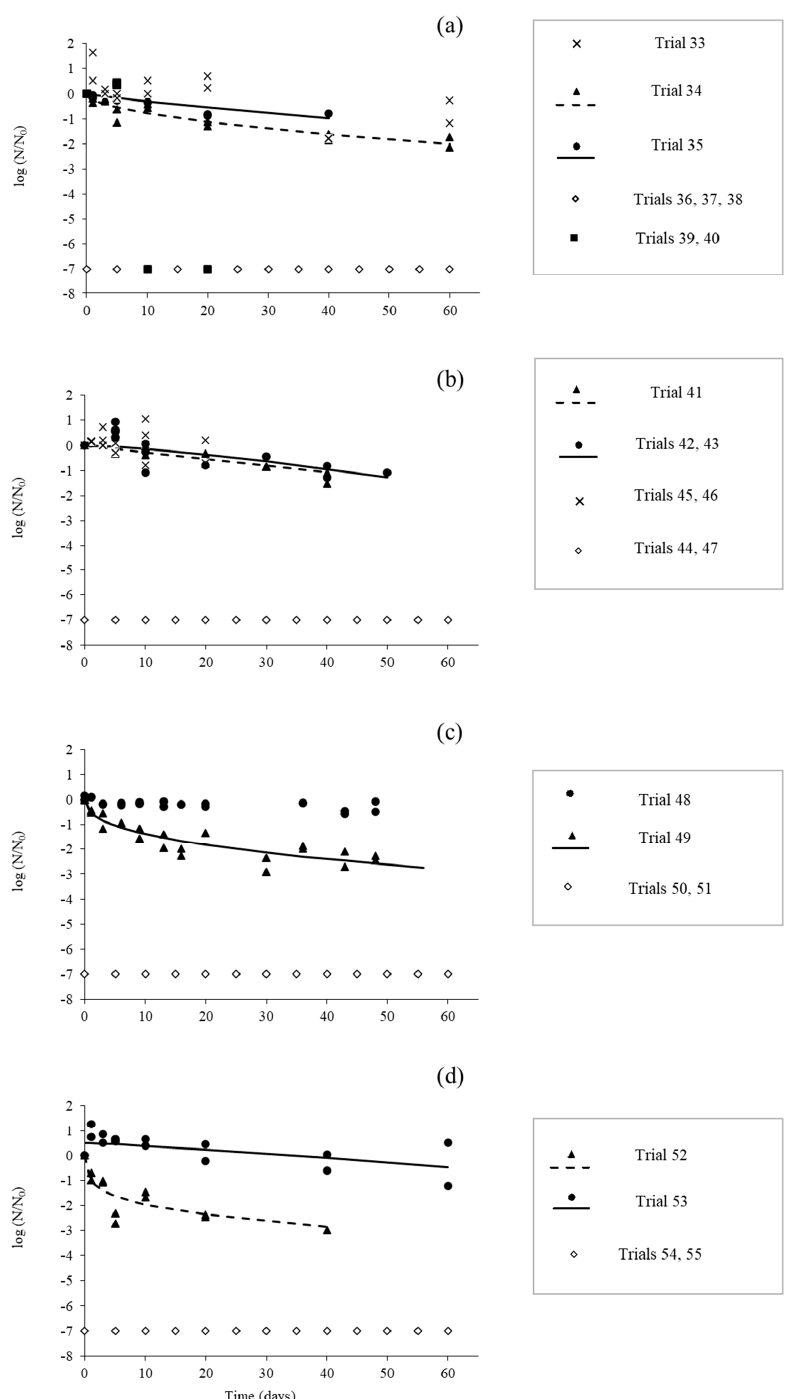
Figure 4. L. monocytogenes survival and inactivation during the storage at 7 ◦ C of pressurized dry- cured ham (DCH) with an a w ( a ) 0.870–0.915, ( b ) 0.919–0.920, ( c ) 0.940, and ( d ) 0.950. Symbols correspond to observed counts and lines to the fit of the Weibull model (Equation (2)) to data. Empty symbols correspond to replicates where the pathogen was not